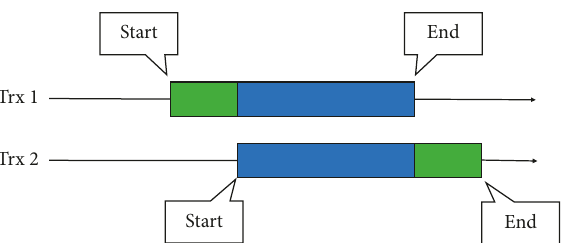
Figure 4: Data parallel replication schematic.